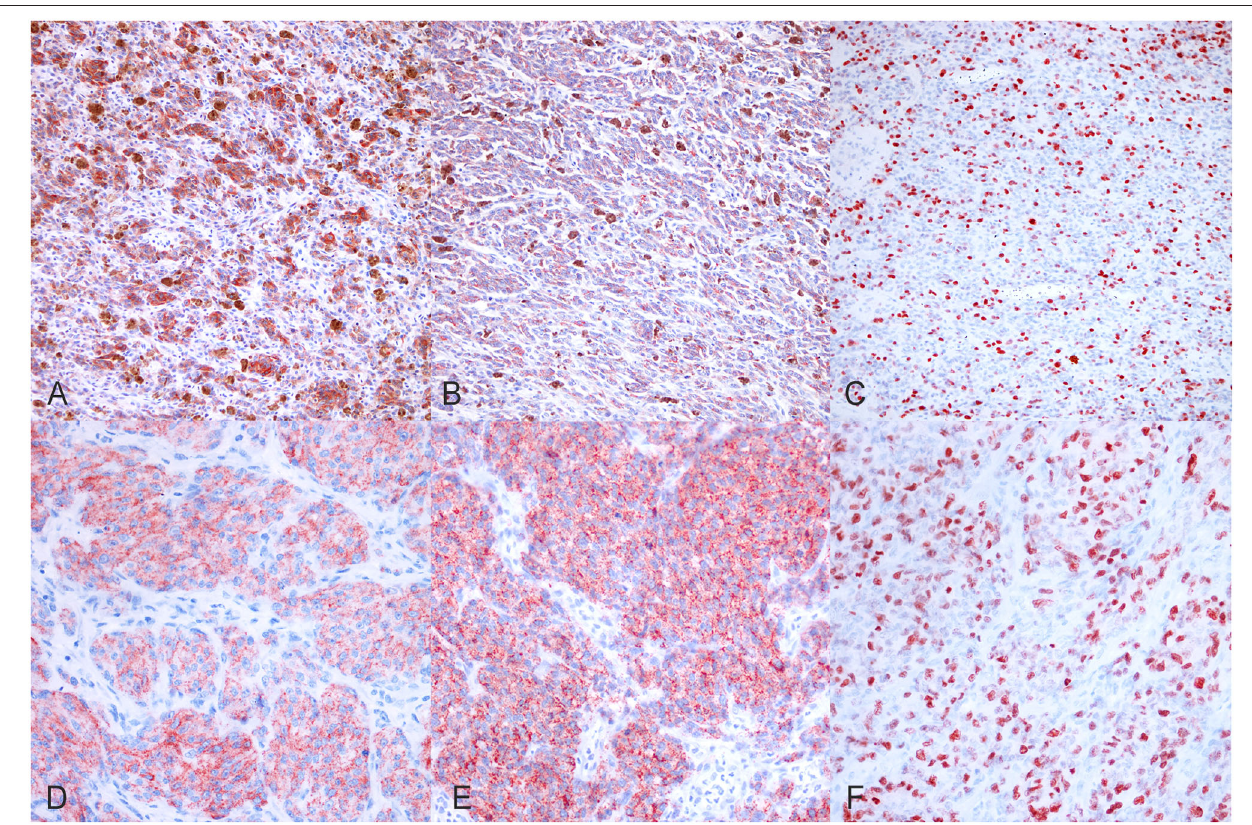
FIGURE 1 | Immunohistochemical results. (A) Canine, Oral melanoma (palate). Multifocal, moderate, finely granular, cytoplasmic Melan A immunolabeling (200x, AEC and hematoxylin). (B) Canine, Oral melanoma (palate). Multifocal, moderate, finely granular, cytoplasmic PNL2 immunolabeling (200x, AEC and hematoxylin). (C) Canine, Oral melanoma (palate). Nuclear immunolabeling of Ki-67 (200x, AEC and hematoxylin). (D) Canine, Oral melanoma (gingiva). Diffuse, finely granular, marked, cytoplasmic Melan A immunolabeling (400x, AEC and hematoxylin). (E) Canine, Oral melanoma (gingiva). Diffuse, finely granular, marked, cytoplasmic PNL2 immunolabeling (400x, AEC and hematoxylin). (F) Canine, Oral melanoma (gingiva). Nuclear immunolabeling of Ki-67 (400x, AEC and